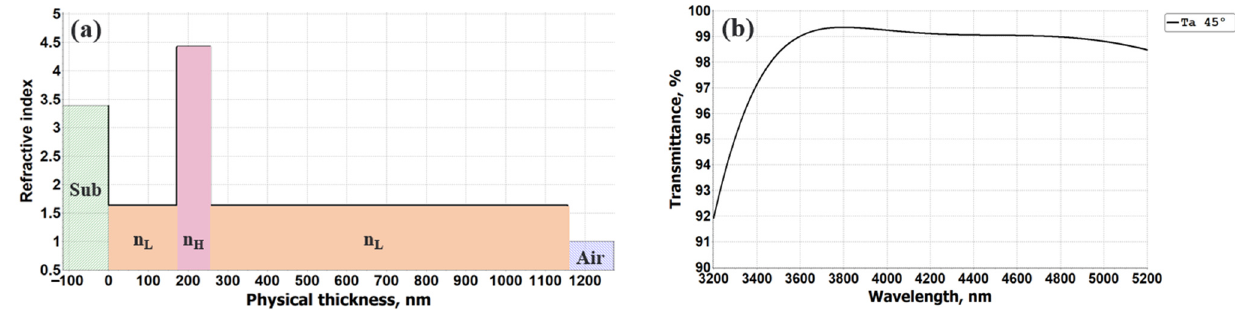
Figure 6. Layer-thickness and index profile ( a ) and theoretical transmittance ( b ) of the AR